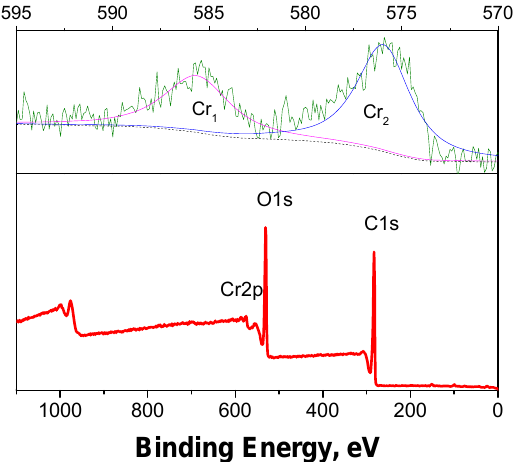
Figure 11. XPS survey spectrum of solid product and high-resolution spectrum of Cr 2p.